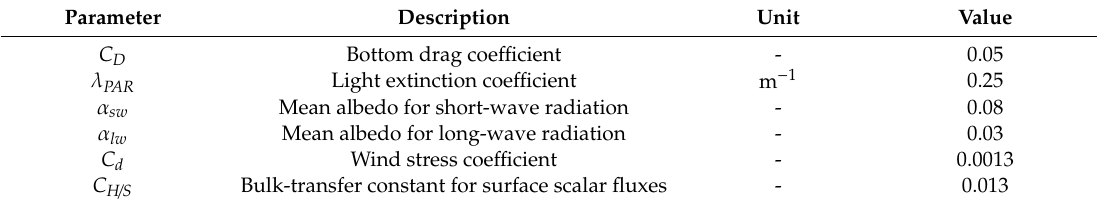
Table 1. Parameters used in the AEM3D simulations.